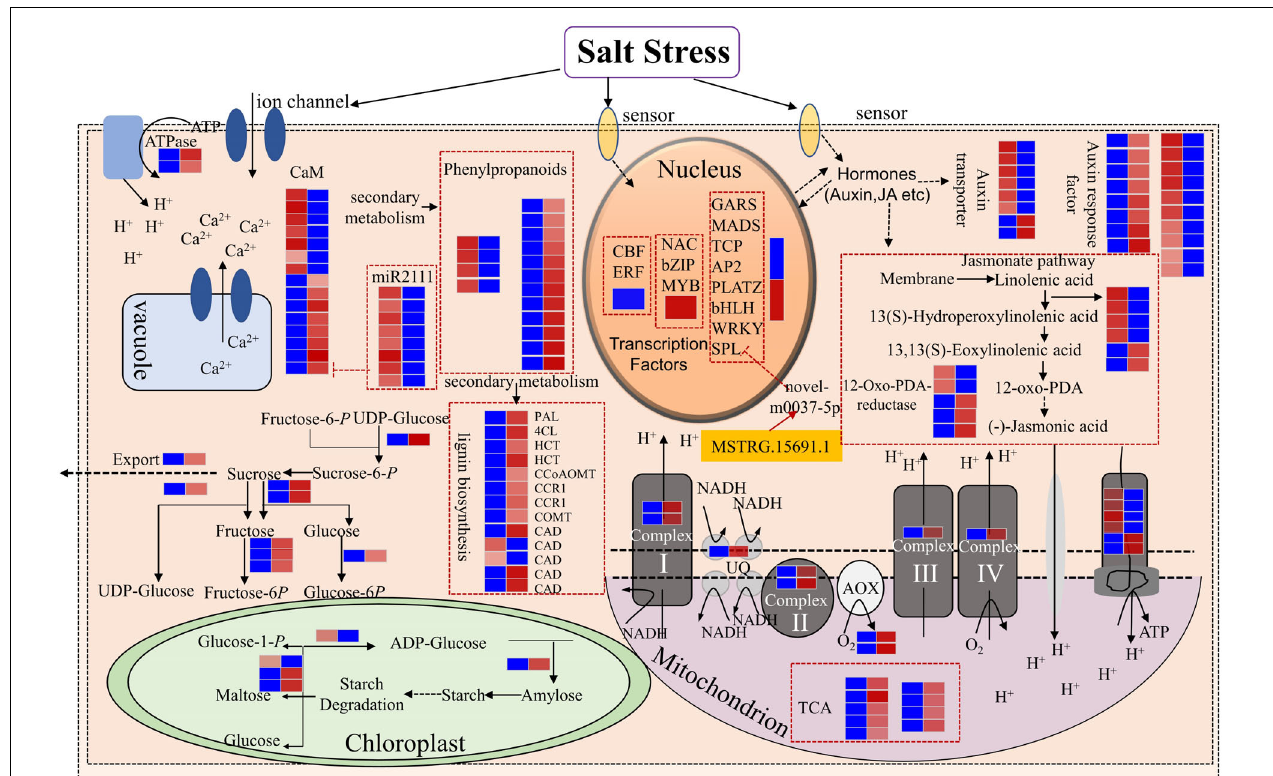
FIGURE 10 | The important pathways of Medicago truncatula ’s response to salt stress and the relationship between DEmRNAs and ceRNAs. Blue boxes represent lower expression lever and red boxes represent higher expression